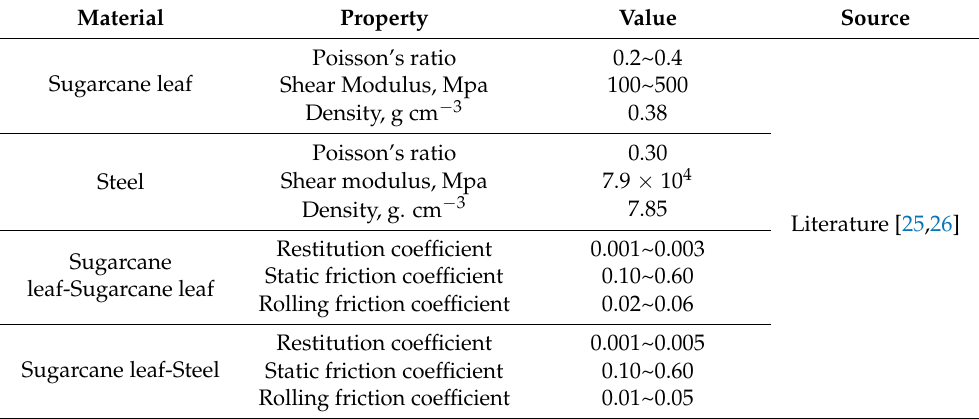
Table 1. Parameters required for DEM simulation.